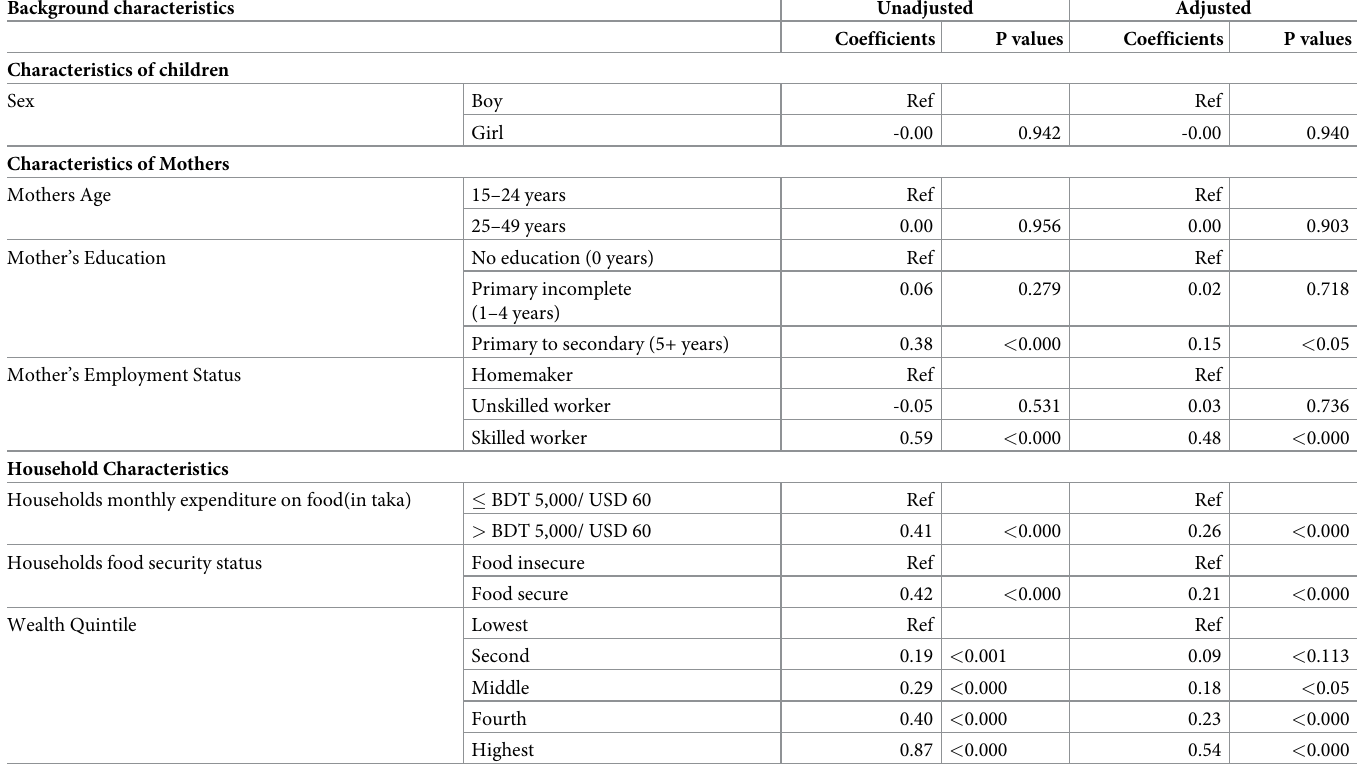
Table 3. Association of food security and socioeconomic factors with Dietary Diversity Score (DDS) among children aged 6-59months in rural areas of Bangladesh, 2014. Background